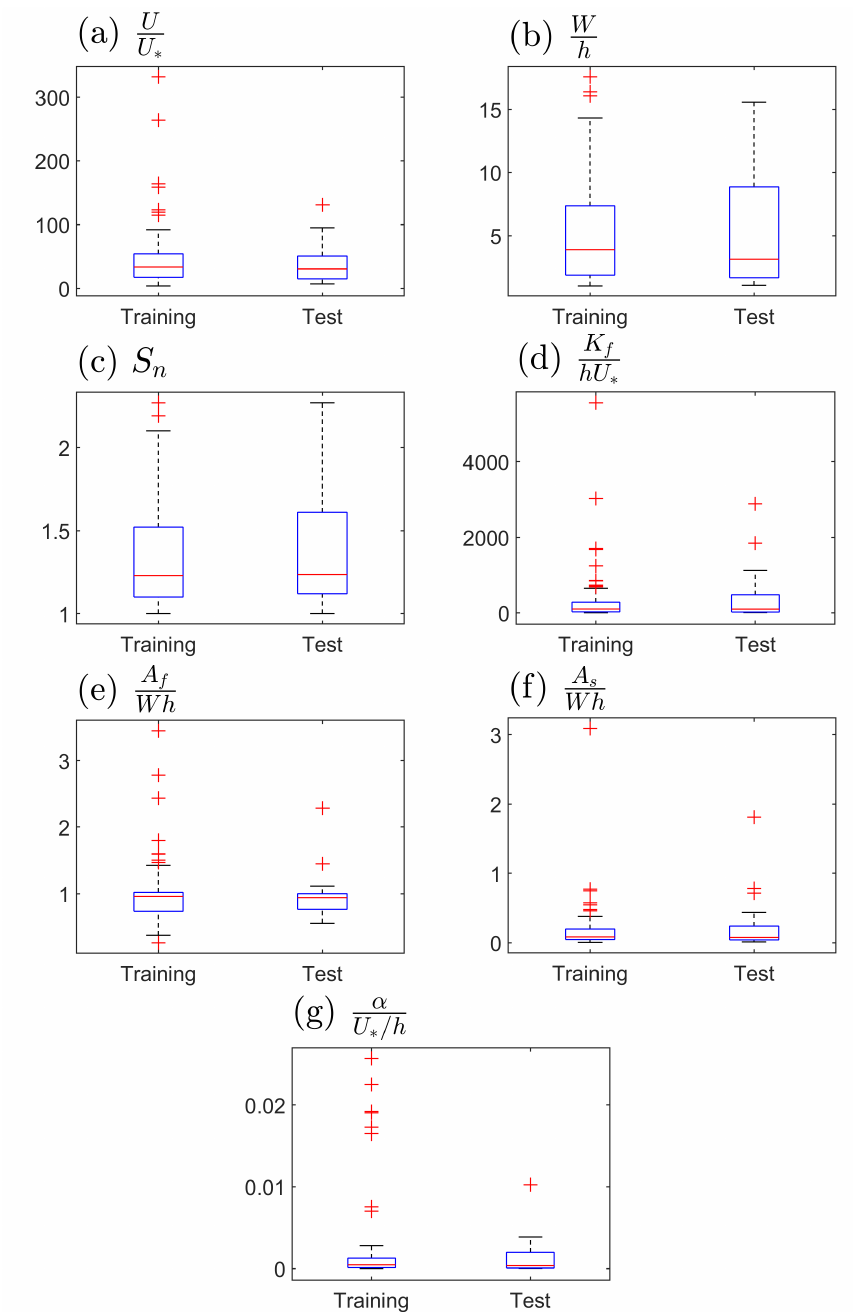
K f A f . ( e ) . ( f ) A s . ( g ) α hU ∗ Wh Wh U ∗ / h